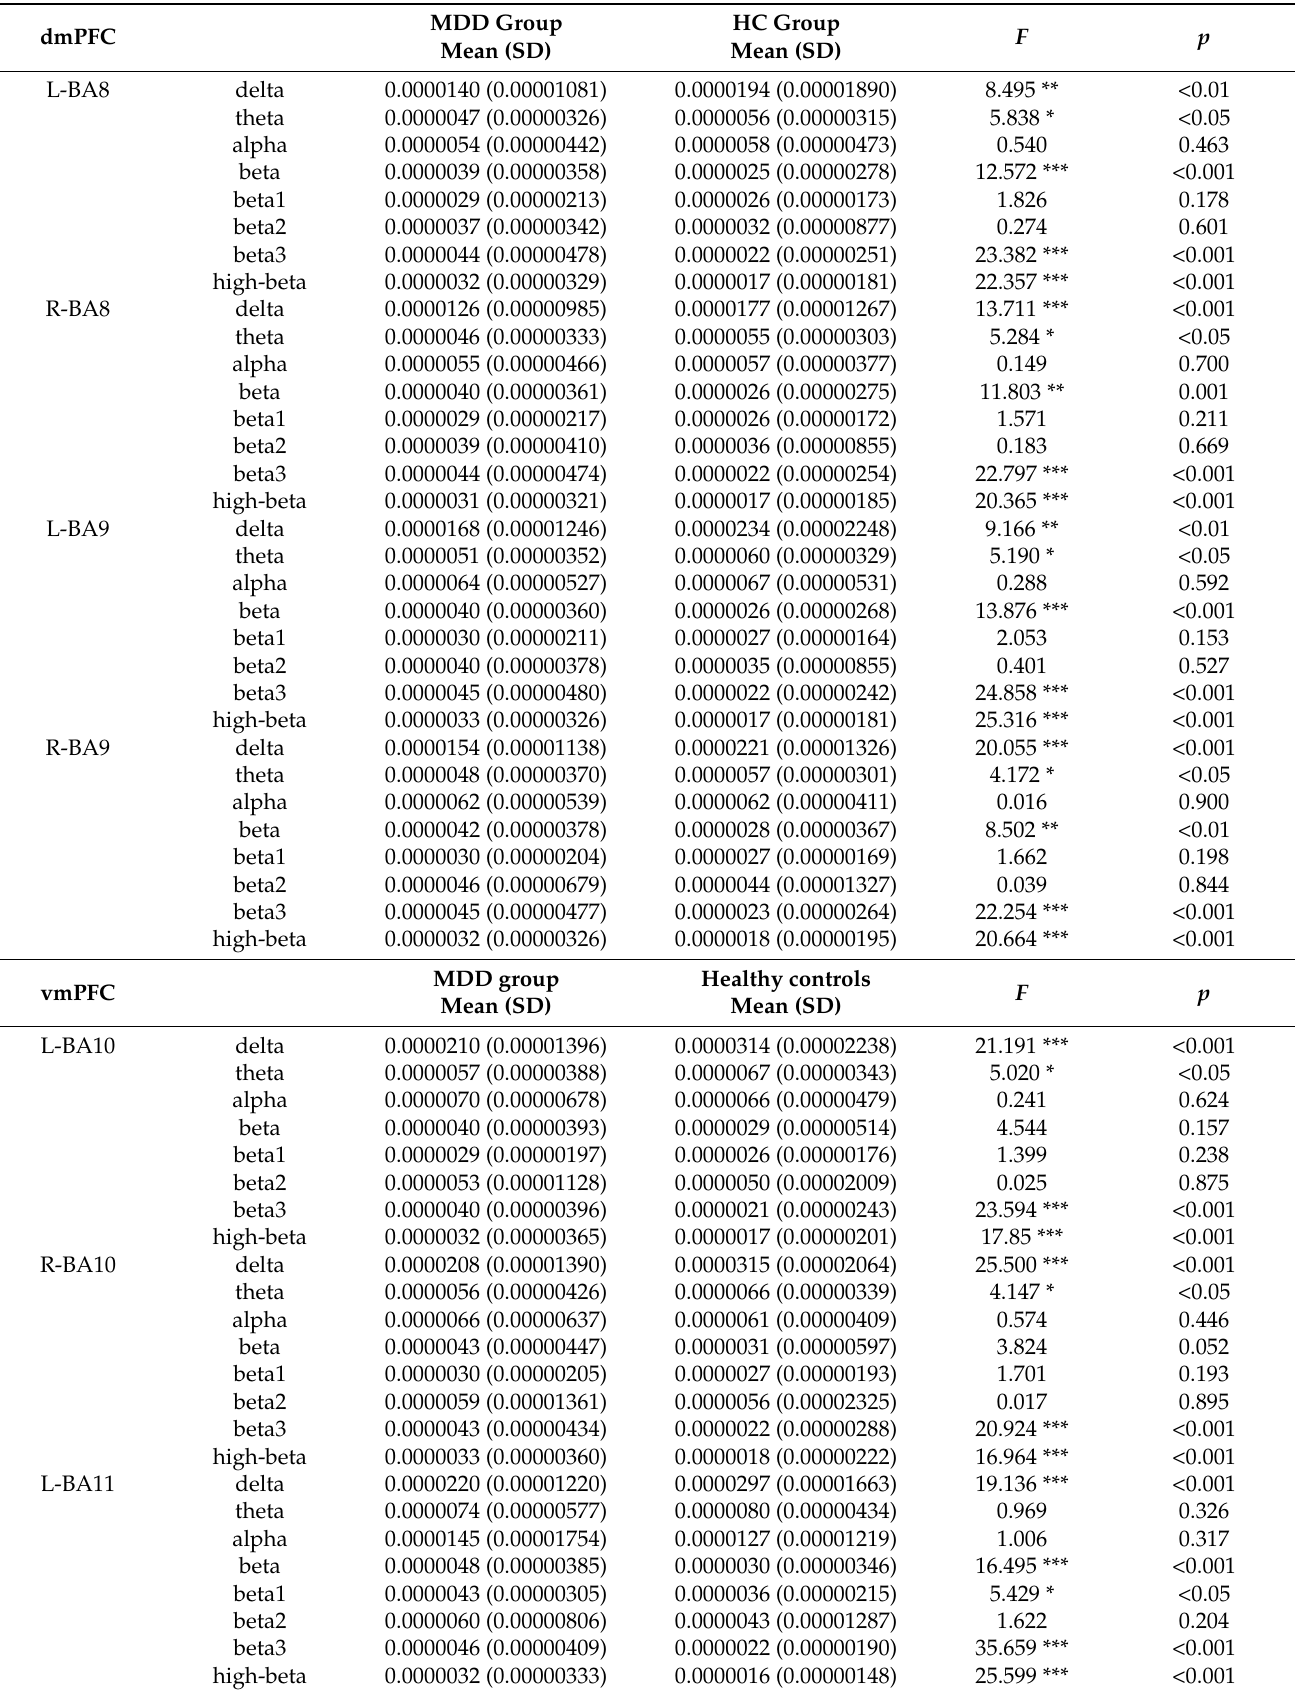
Table 2. Deep brain activity in dmPFC, vmPFC, dlPFC, vlPFC, OFC, and PCC for MDD and HC